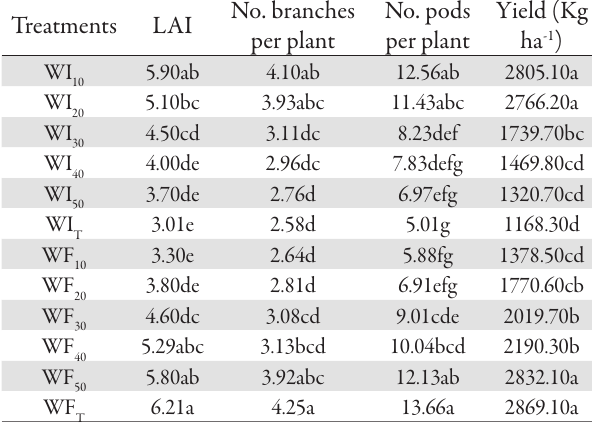
Tab. 2. Means comparison for leaf area index (LAI), number of branches, number of pods and yield of common bean at different treatments of weed interference and weed free periods